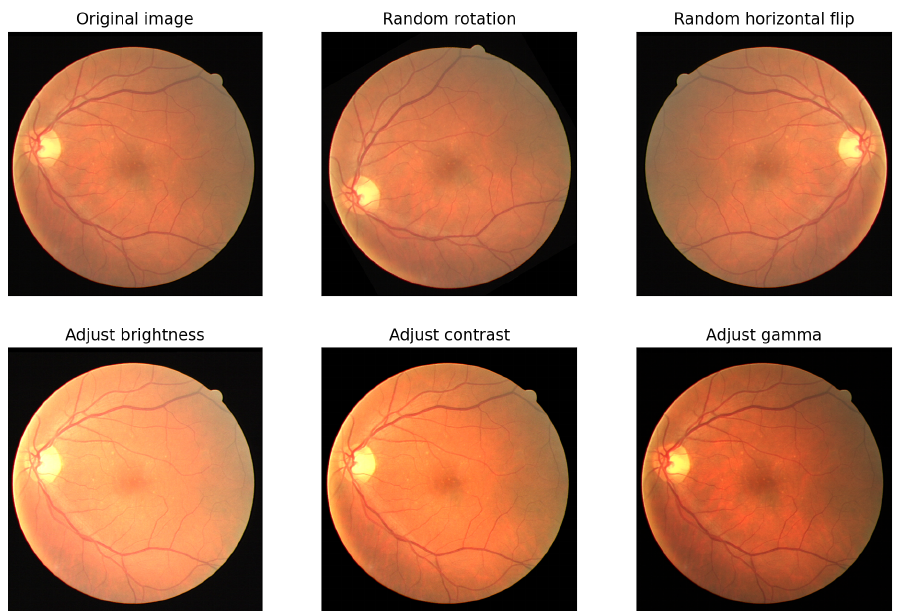
Figure 2. Example of the different data augmentation transformations applied to one of the training